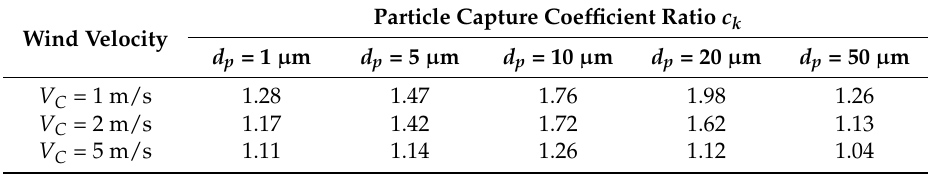
Table 3. Calculation results of particle capture coefficient